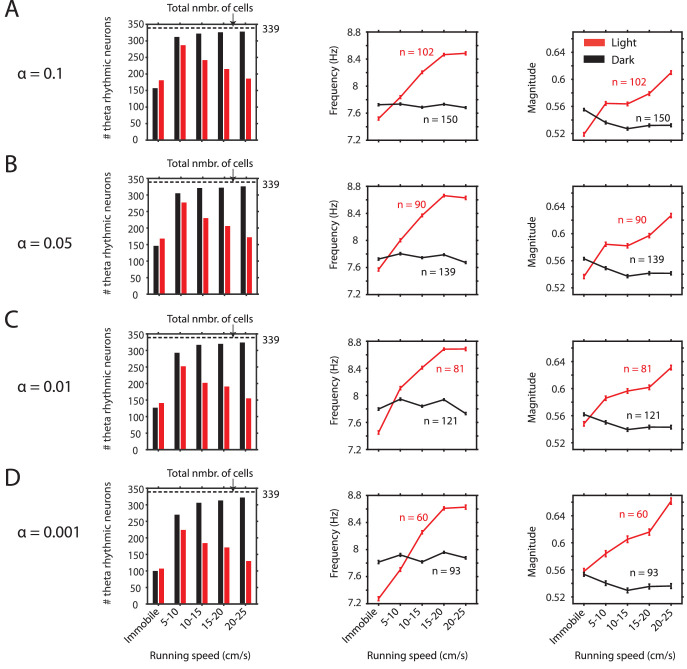
Observed changes in theta rhythmic firing as a function of visual inputs are consistent across a wide range of significance levels chosen to identify theta rhythmic neurons.(A-D) Results with respect to the number of significant neurons as a function of running speed (first panel) and the frequency (second panel) and magnitude (third panel) of theta rhythmic firing as functions of running speed are consistent across different significance levels alpha for theta rhythmic firing used as threshold criteria for classification of theta rhythmic neurons. Data in second and third panels show mean ± s.e.m.( A) alpha = 0.1, (B) alpha = 0.05, (C) alpha = 0.01, (D) alpha = 0.001.